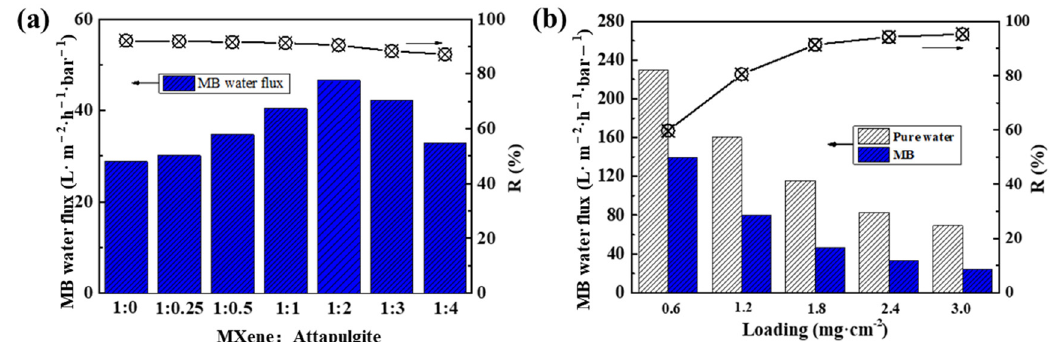
Figure 7. ( a ) Effect of mass ratio of MXene to attapulgite on MB flux and rejection rate of composite membranes; ( b ) effect of MXene/attapulgite composite loading on the obtained pure water flux, MB flux and rejection rate.